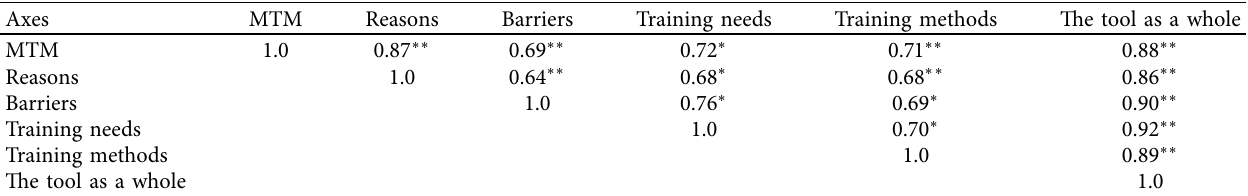
Table 4: The coefficient of internal consistency, Cronbach’s alpha, return constancy of the axes, and the total score. Axes Repetition constancy (Pearson correlation coefficient) Internal consistency (Cronbach’s alpha) MTM 0.92 0.85 Reasons 0.86 0.88 Barriers 0.93 0.94 Training needs 0.92 0.91 Training methods 0.91 The tool as a whole